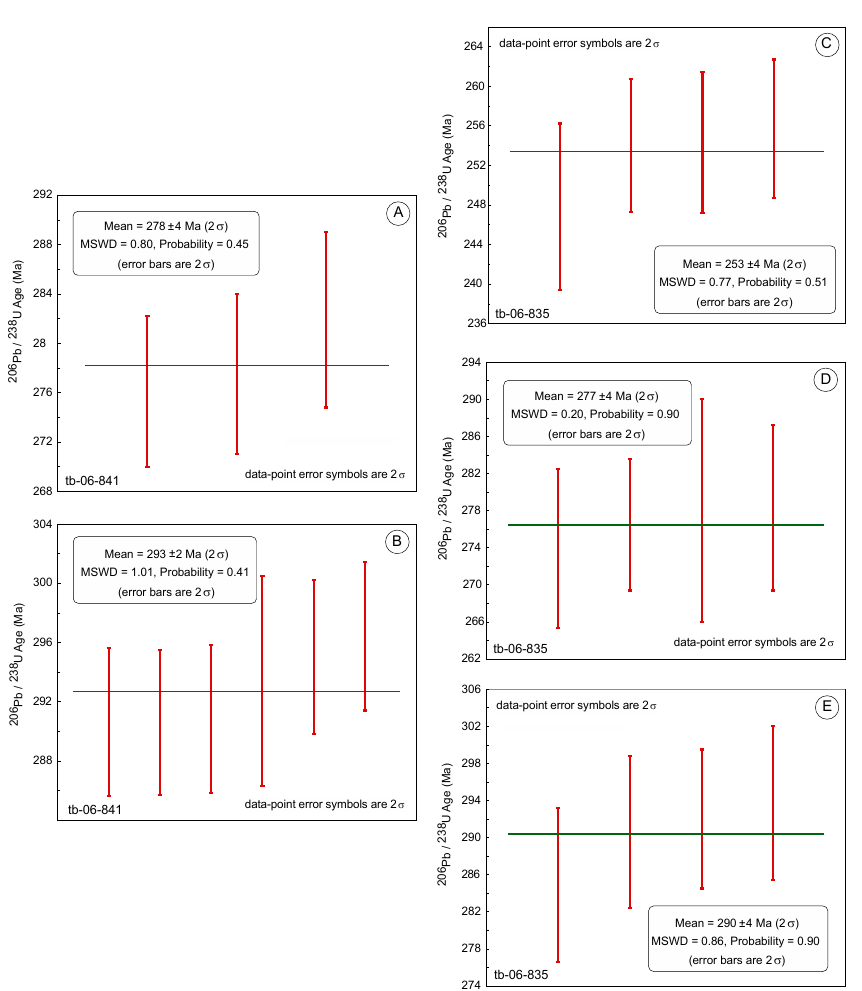
Figure 5. Weighted mean age of the youngest zircon populations: ( A , B ) from sample tb-06-841; ( C – E ) from sample tb-06-835.